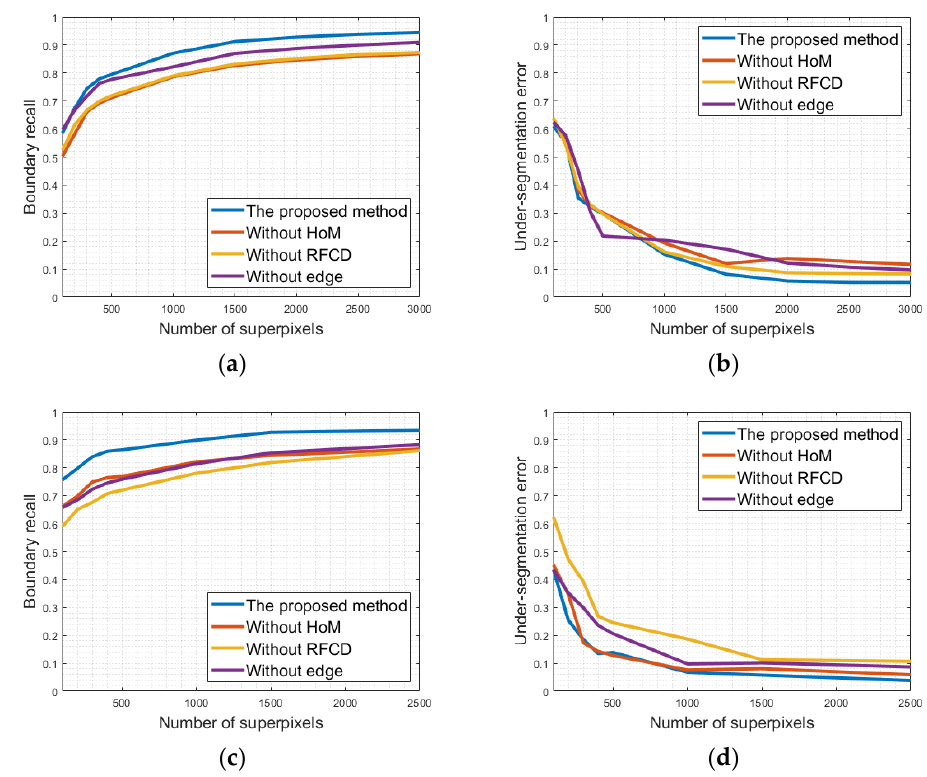
Figure 13. Segmentation BR and UE comparison of the proposed method with different distance measures, i.e., removing HoM, RFCD, or edge information; ( a ) and ( b ) results of the three methods with ESAR data; ( c ) and ( d ) results of the three methods with AIRSAR data.